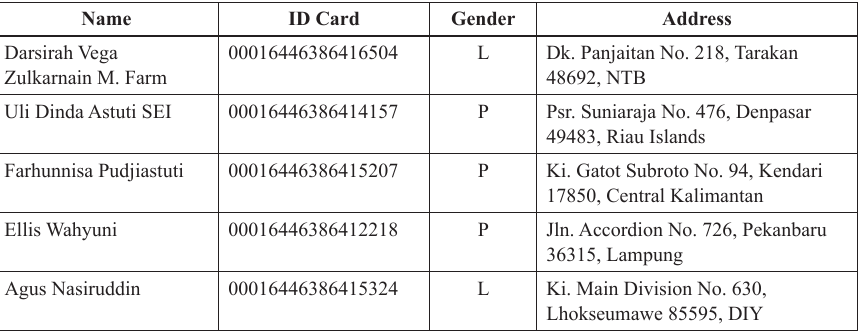
Table 1. Example of village population data